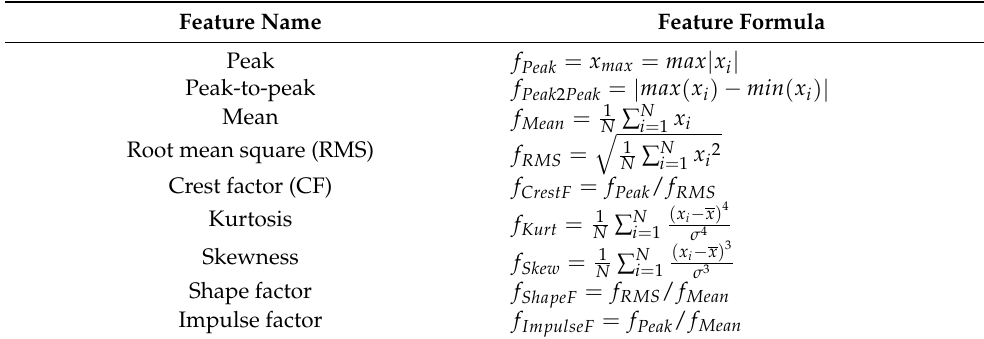
Table 5. Extracted time features from raw signals. x i , is the signal (observation) at time i , i = 1, . . . , S N , S N is the length of the signal segments, x is the mean value of x i , i = 1 . . . S N , and σ 3 σ 4 are third and the fourth moment of x i , i = 1 . . . S N ,